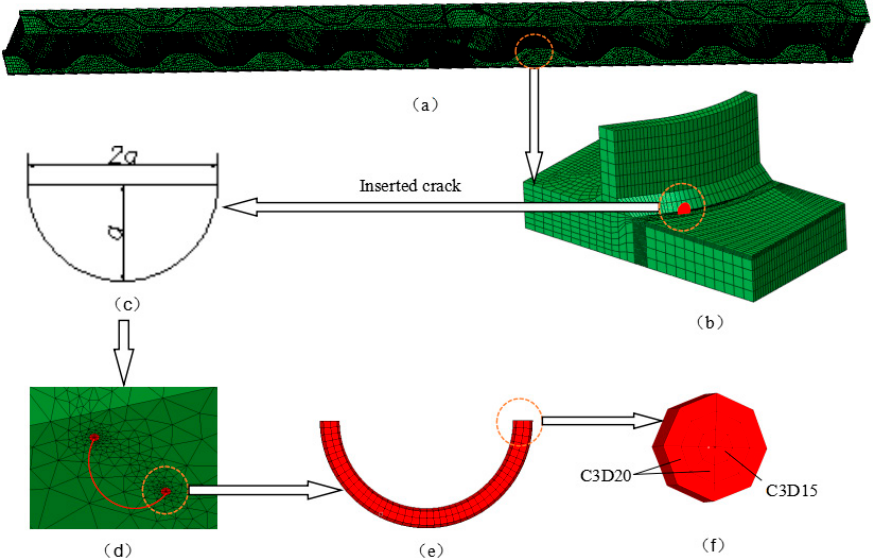
Figure 8. Crack model scheme of the specimen: ( a ) Global FEA model of the girder; ( b ) sub-model of cracked region; ( c ) semi-elliptic initial crack; ( d ) elements meshing of crack region; ( e ) crack front; ( f ) composition of crack front elements.